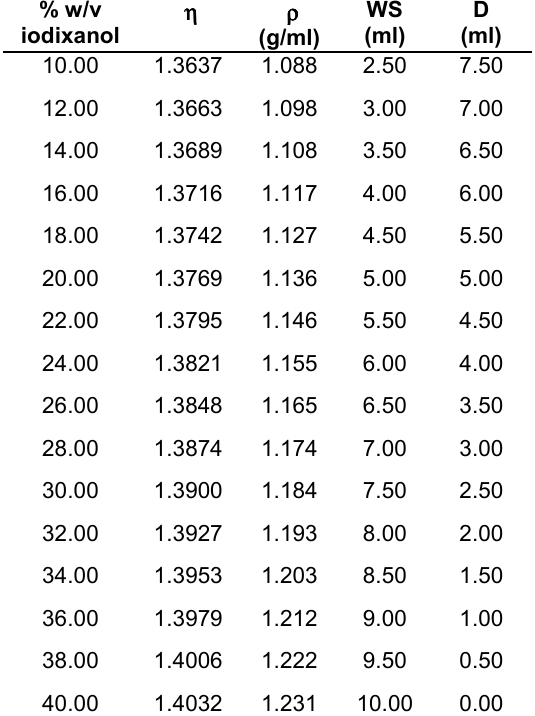
Density ( ρρρρ ) and Refractive Index ( ηηηη ) of Iodixanol Solutions: Dilution of 40% Iodixanol Working Solution, ρρρρ = 1.231 g/ml (WS) with the 12.25% Sorbitol Diluent (D) % w/v